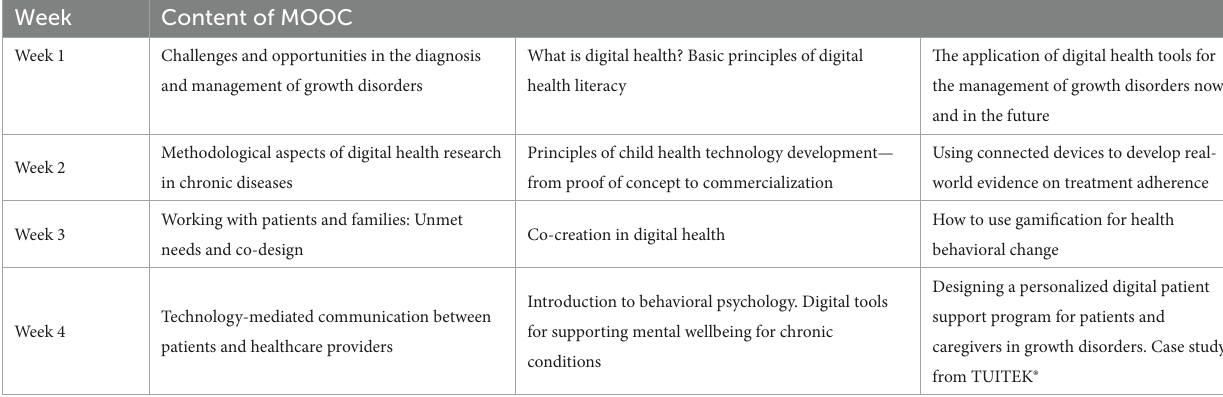
TABLE 1 Content of the MOOC over 4